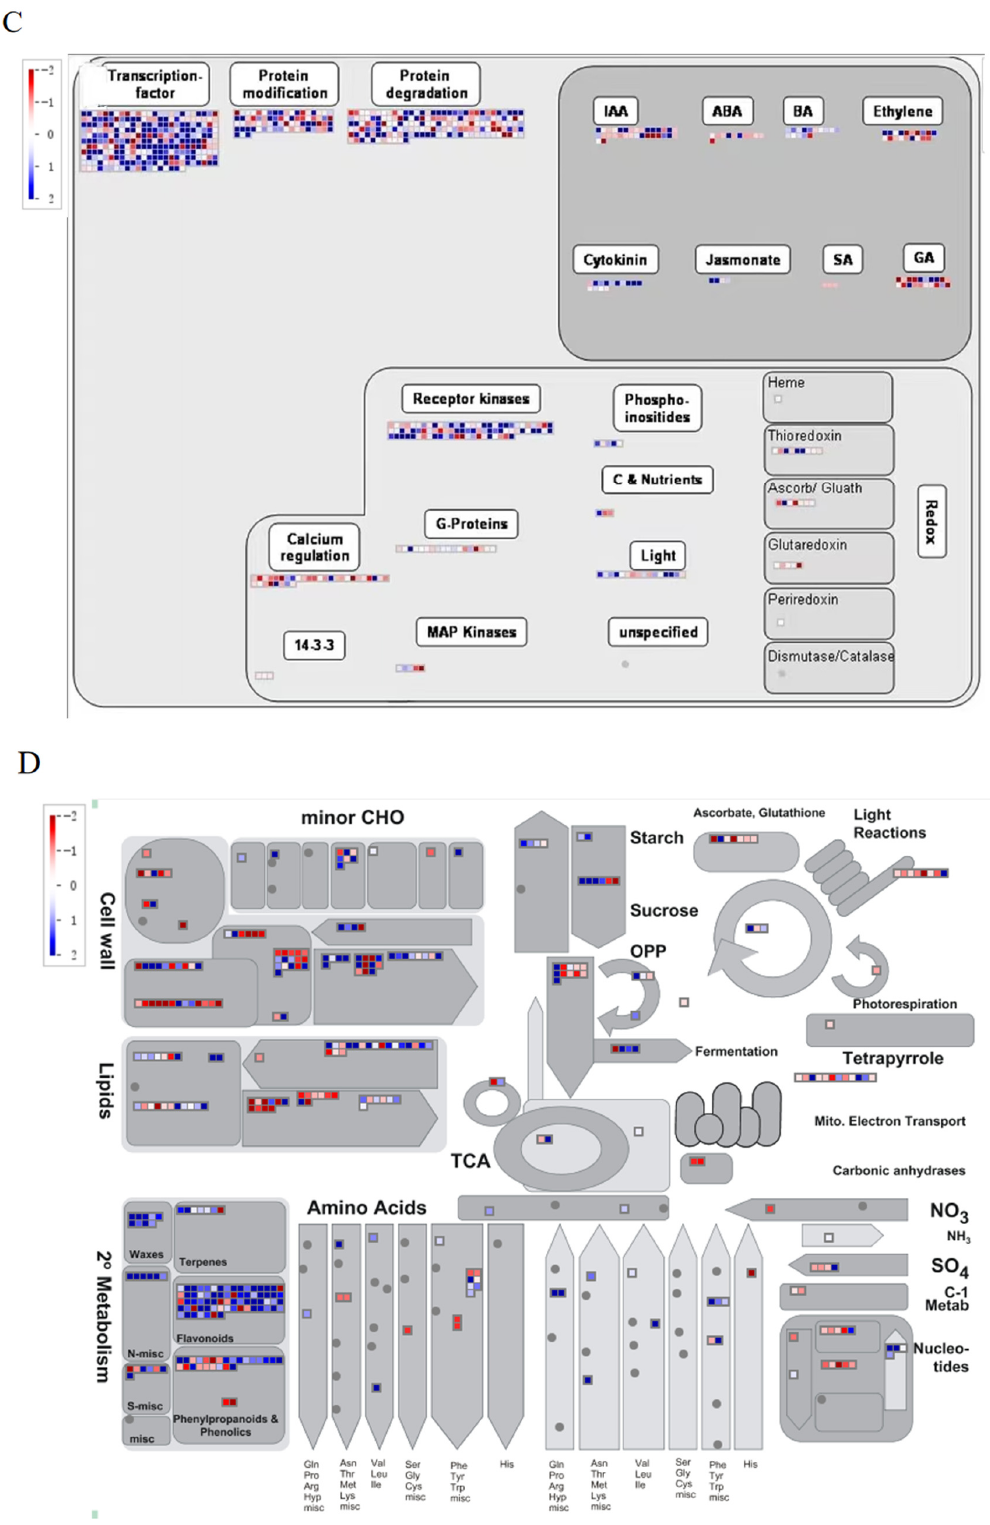
Figure 7. Clustering patterns of DEGs generated using the MapMan tool. ( A ) Cellular response of DEGs in L_SR-vs.-L_CI. ( B ) Cell functions of DEGs in L_SR-vs.-L_CI. ( C ) Biological regulation of DEGs in L116 vs. L115. ( D ) Metabolic regulation of DEGs in L_SR-vs.-L_CI.